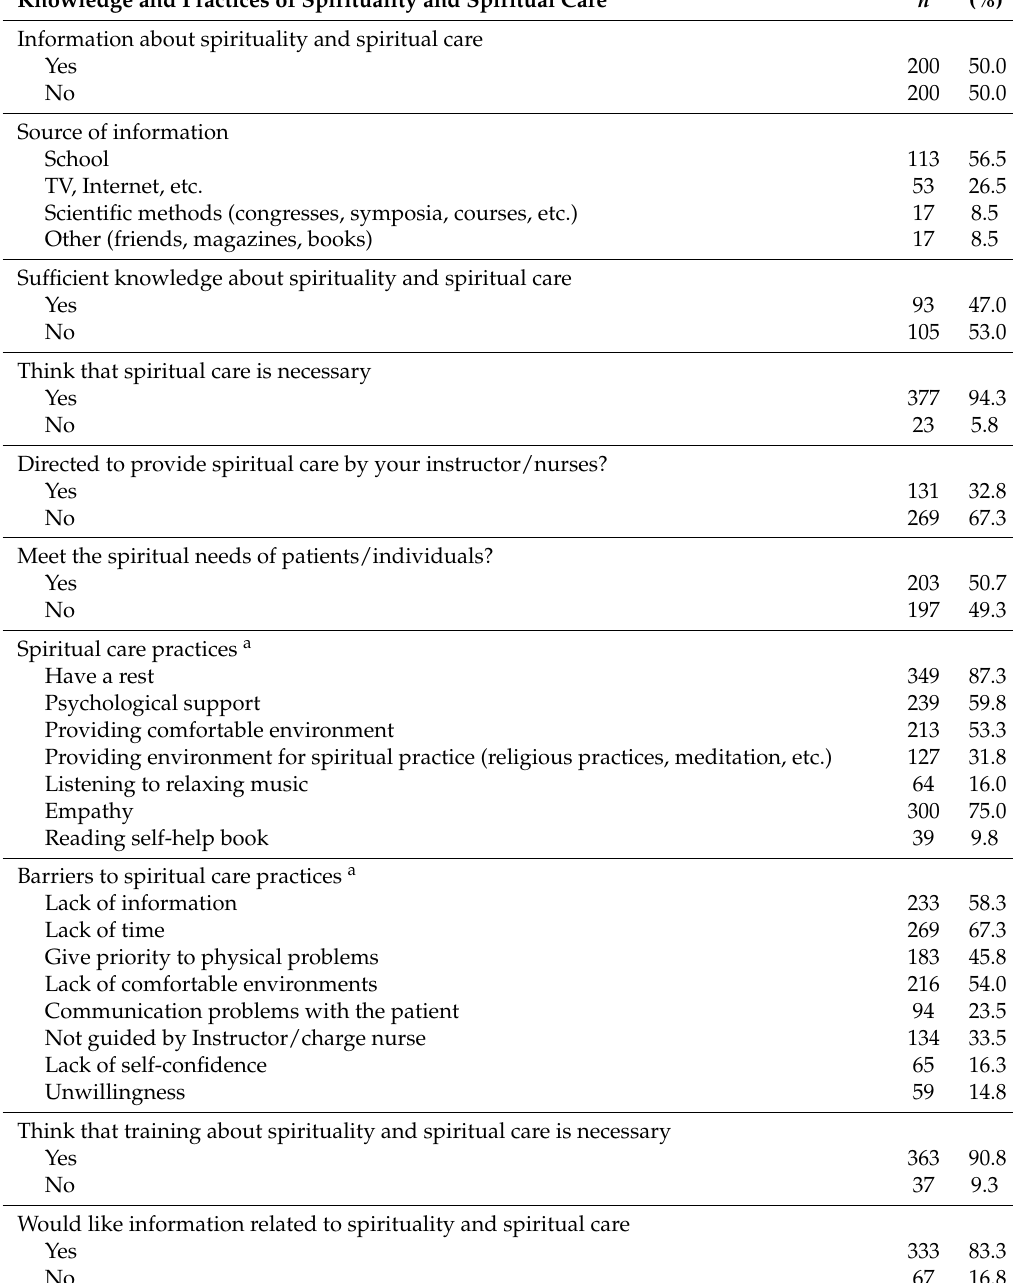
Table 2. Nursing students’ knowledge and practices of spirituality and spiritual care ( n =